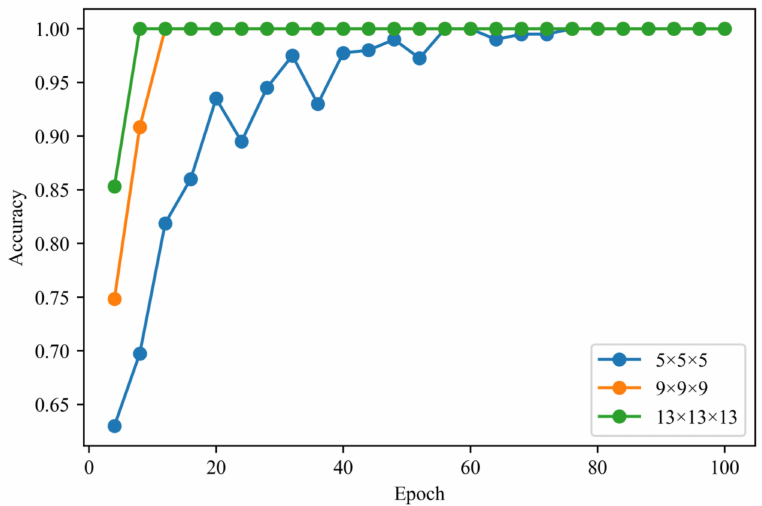
Figure 11. Relationships between the epoch number and prediction accuracy determined by applying the validation data. The prediction accuracy was equal to the ratio of the number of morphologies that predicted the correct class to the number of validation data instances. The blue line, orange line, and green line correspond to the prediction accuracies of the kernels with sizes of 5 × 5 × 5, 9 × 9 × 9, and 13 × 13 × 13,